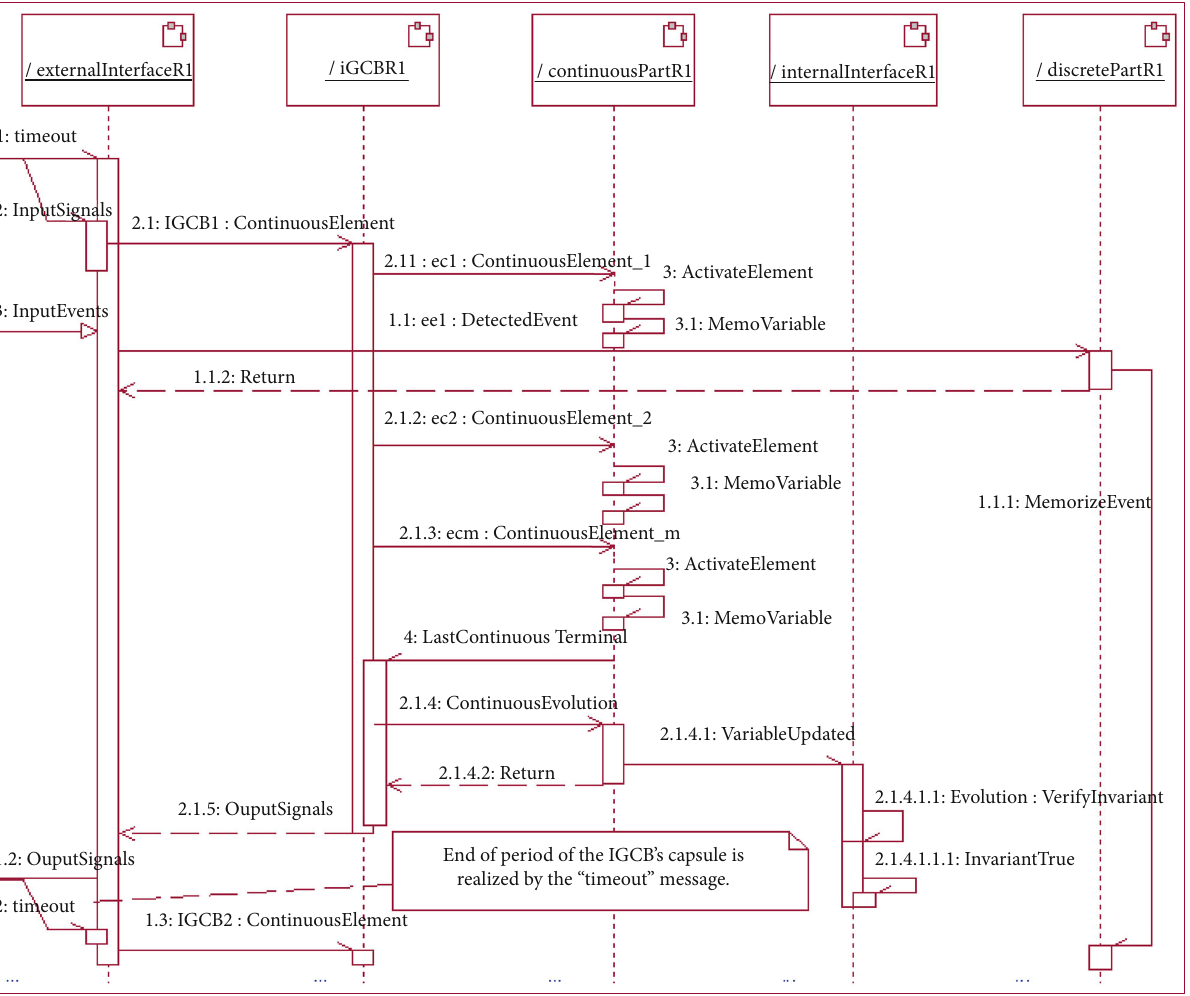
Figure 8: Sequence diagram of the real-time capsule pattern for the Q-UAV